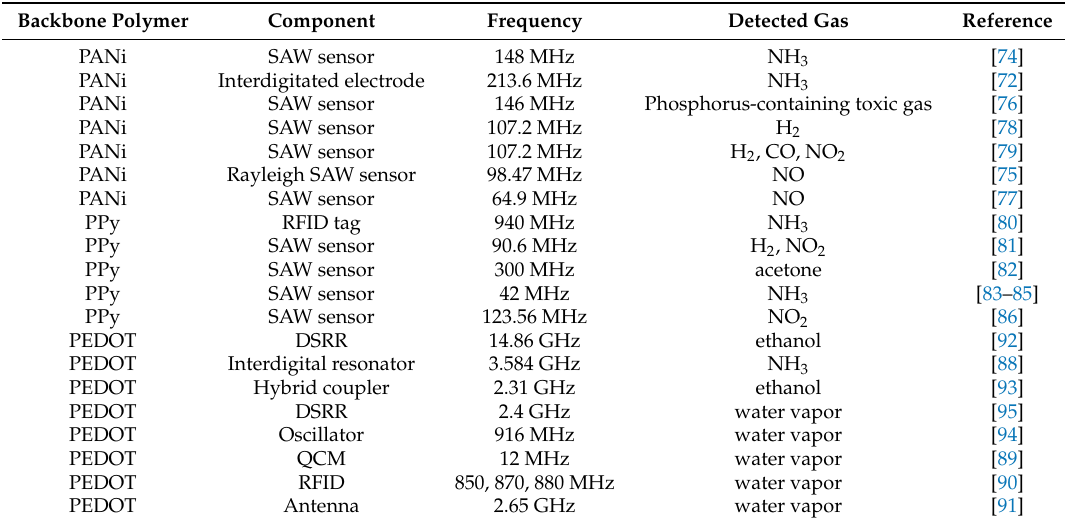
Table 2. Radio-Frequency/Microwave Chemical Gas Sensors Using Conducting Polymers. Backbone